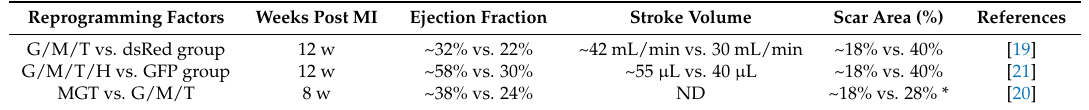
Table 1. Comparison of functional outcomes of in vivo direct reprogramming studies aimed to regenerate the mouse